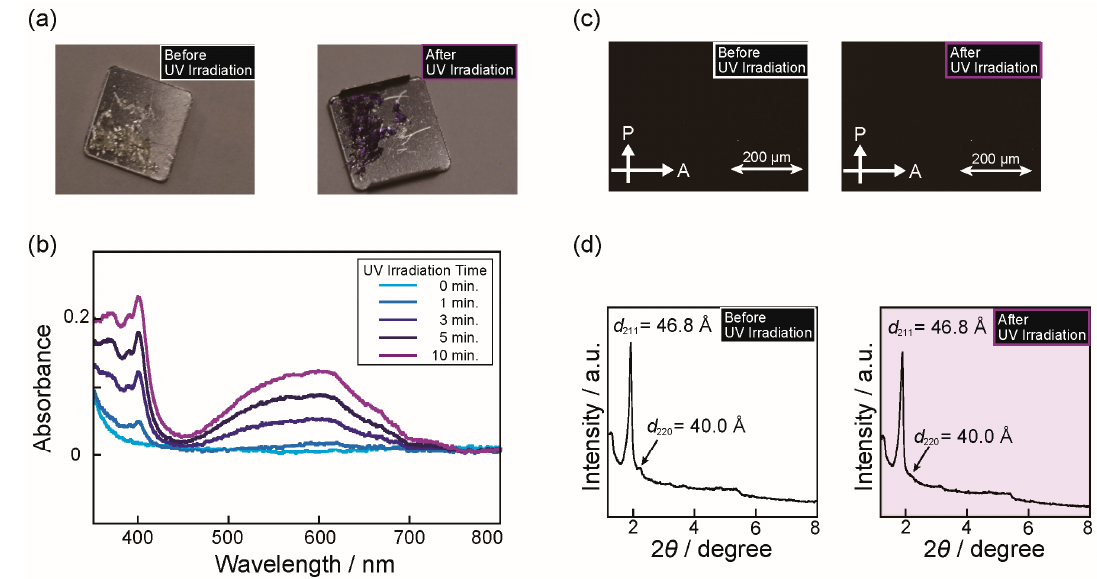
Figure 3. ( a ) Color change of V 2+ ZI-16/HTf 2 N mixture before and after UV irradiation for 15 min; ( b ) UV-vis spectra of V 2+ ZI-12/HTf 2 N mixture before and after UV irradiation; ( c ) Polarizing optical microscope images of V 2+ ZI-16/HTf 2 N mixture before and after UV irradiation; ( d ) X-ray diffraction patterns of V 2+ ZI-16/HTf 2 N mixture at 30 °C in the Cub bi phase before and after UV irradiation.